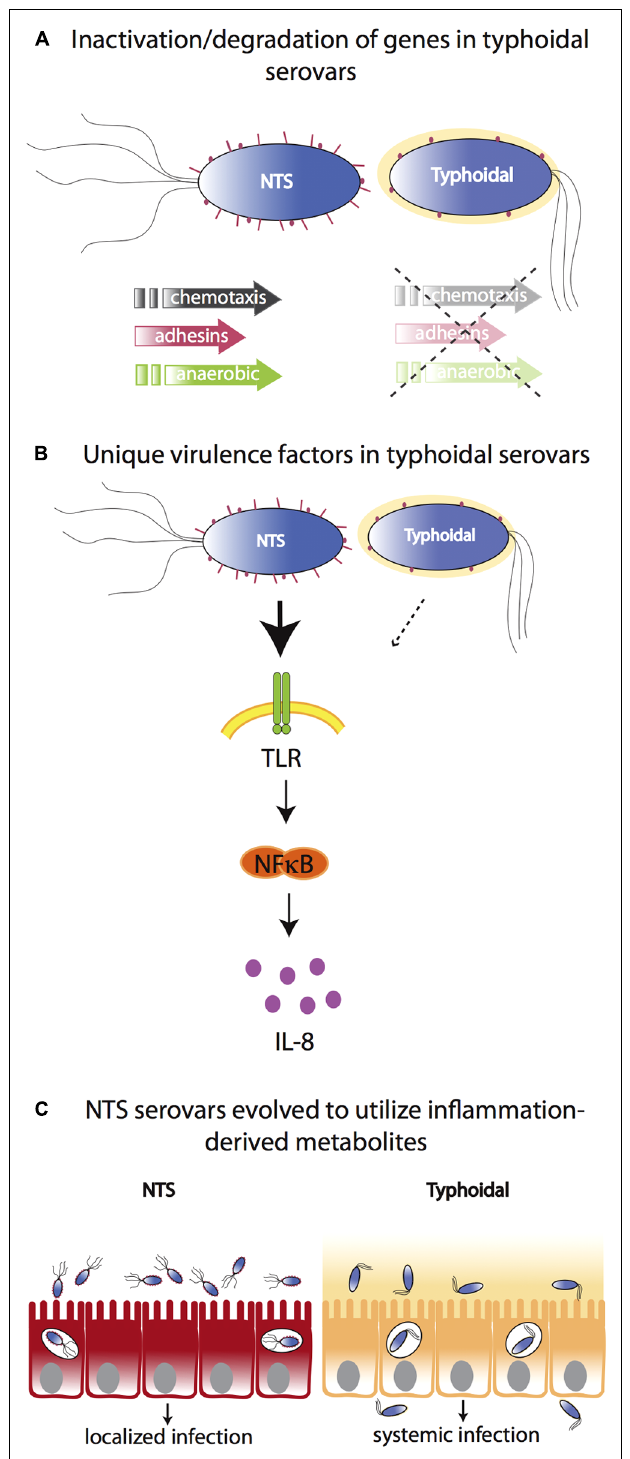
FIGURE 1 | Molecular bases for differences between typhoidal and NTS serovars. (A) Typhoidal serovars possess several inactive/degraded genes compared to NTS serovars such as genes for chemotaxis, adhesion, and anaerobic metabolism. (B) Both typhoidal and NTS serovars possess unique virulence factors. For example, some S. Typhi strains expressVi